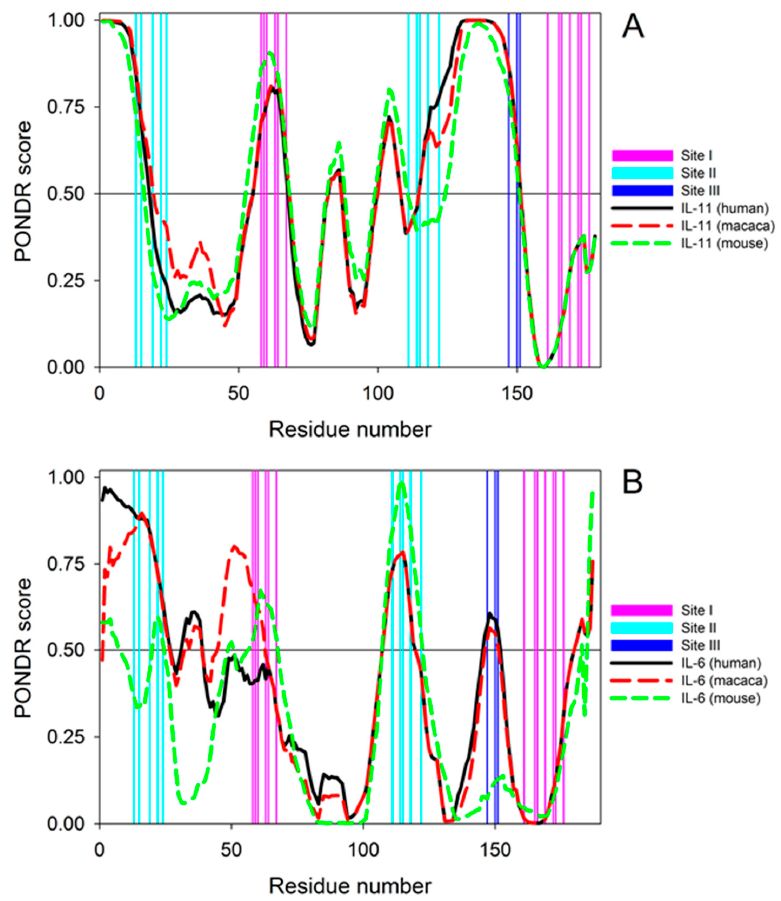
Figure 6. Predictions of per-residue disorder level for mature IL-11 (panel A ) and IL-6 (panel B ) orthologues from human (black solid lines), macaque (red dashed lines), and mouse (green dashed lines), using PONDR ® VLXT algorithm (http://pondr.com/). Positions of sites responsible for recognition of IL-receptors are shown as differently colored vertical bars (pink, cyan, and blue for sites I, II, and III, respectively).